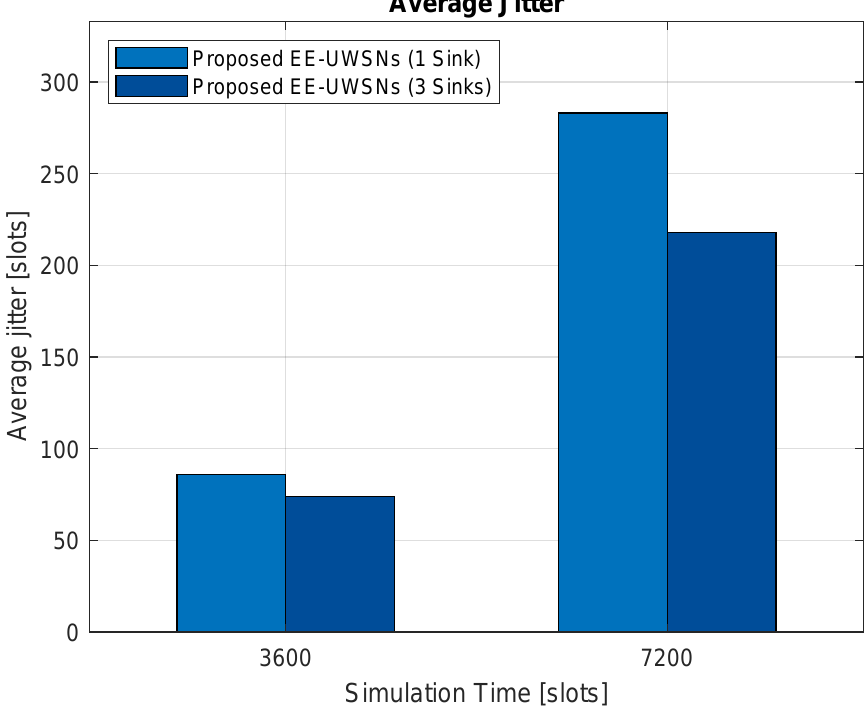
Figure 19. The effect of changing the number of sinks on